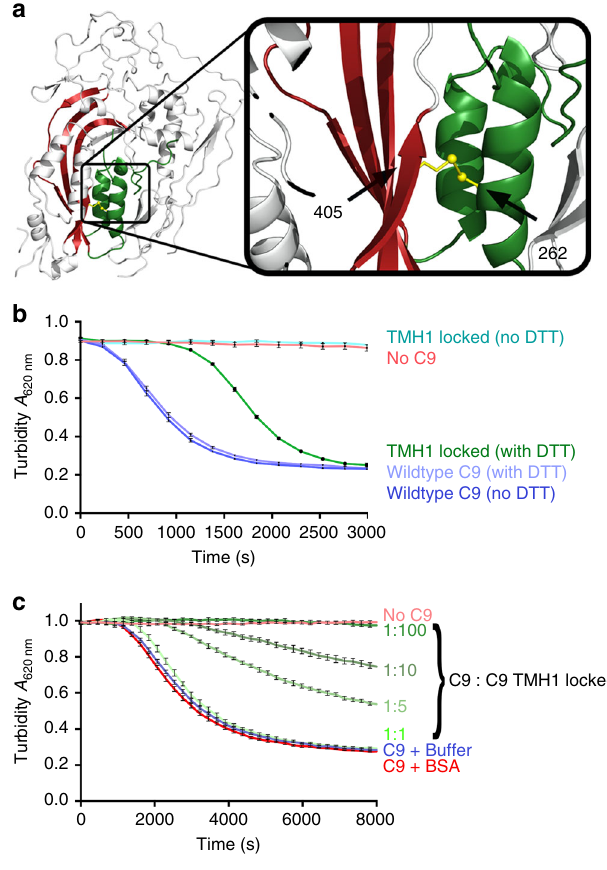
Fig. 2 The C9 TMH1 movement is necessary for pore assembly. a Cartoon model of a C9 monomer (left) disulphide locked mutant (also called C9 mutant with F262C/V405C mutations) (shown as yellow sticks), that links the TMH1 region to β -strand 4 of the MACPF domain (right). b Haemolytic activity of disulphide locked C9 against erythrocytes/antibody/ complement 1 – 8 (EAC1-8). The TMH1 locked (no DTT) alone is